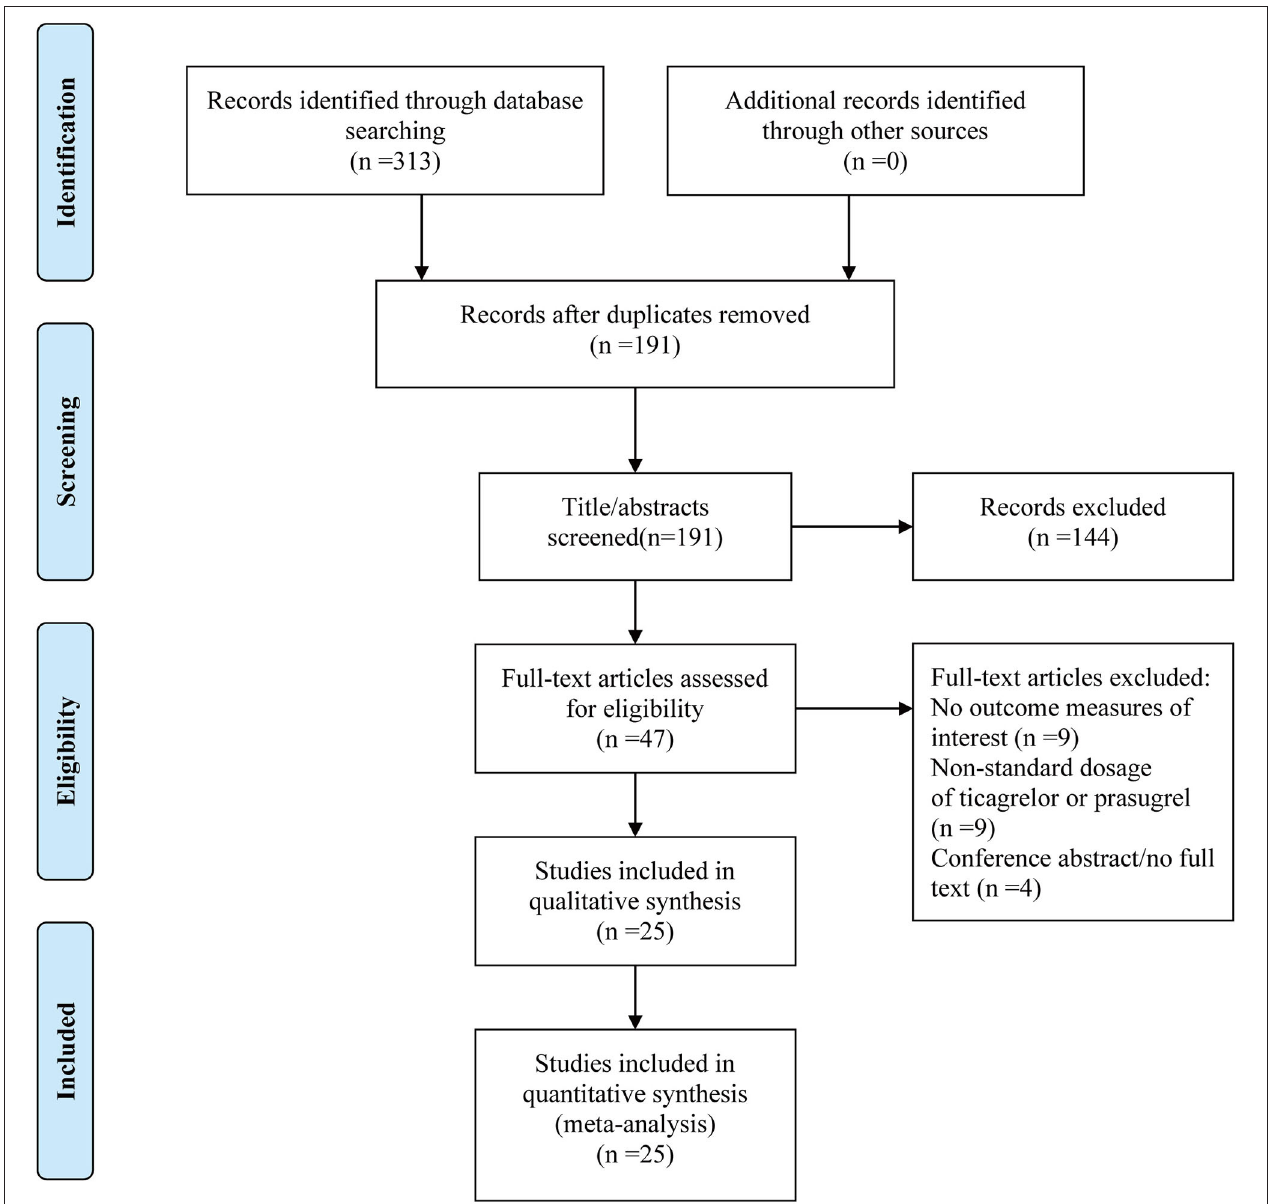
FIGURE 1 | Flow diagram of literature selection and